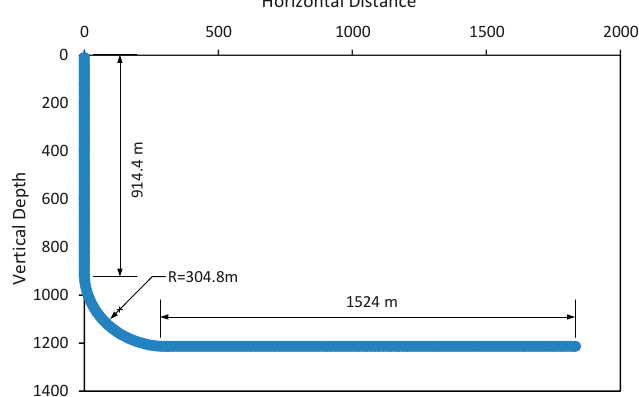
Figure A3. Well profile applied in this study.